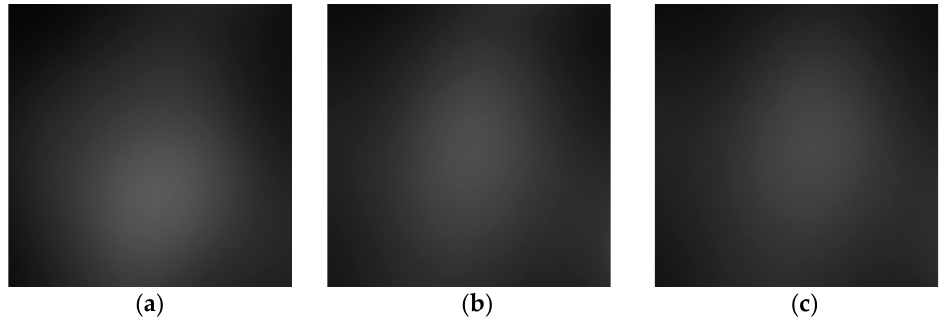
Figure 19. Tactile images according to elasticity: ( a ) 110 kPa, ( b ) 80 kPa, ( c ) 50 kPa.